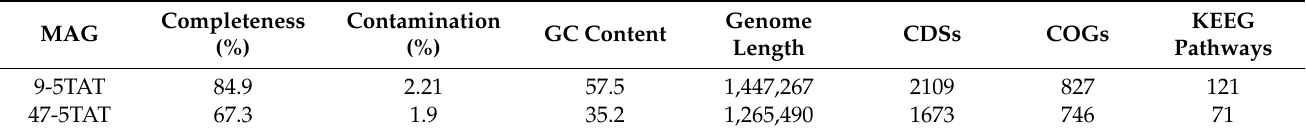
Table 1. Archaeal MAGs used in the present study. CDSs: coding sequences; COGs: orthologous groups of proteins. MAG